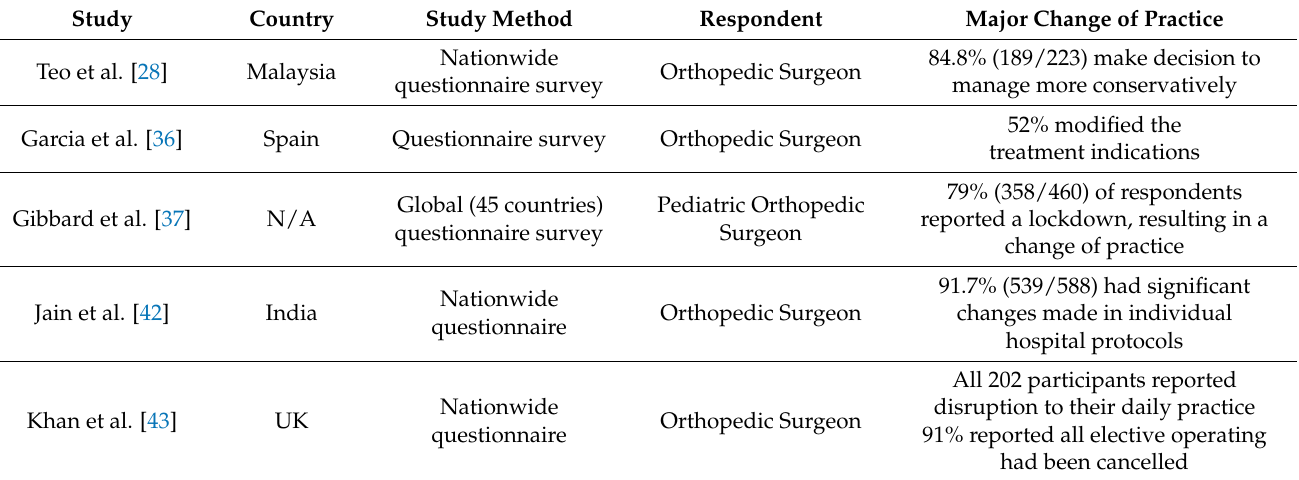
Table 9. Characteristics of relevant publications on change of